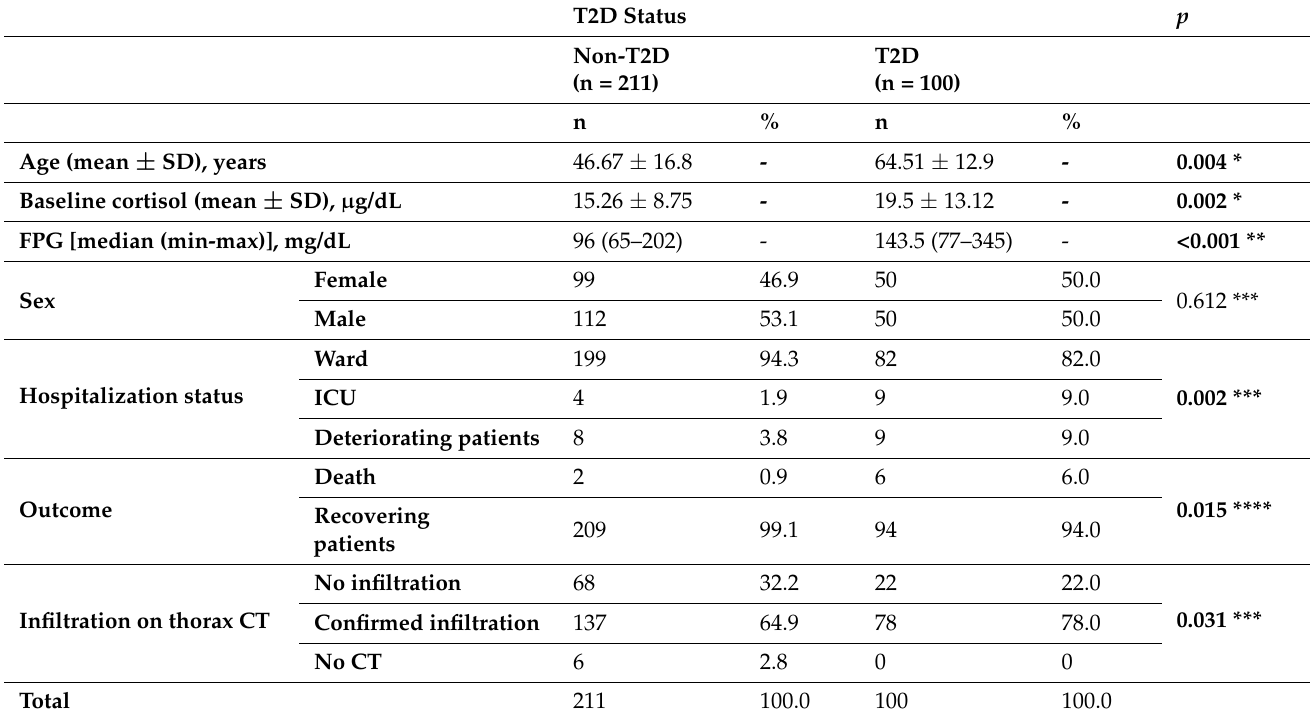
Table 2. Comparison of age, sex, basal cortisol, FPG, hospitalization status, and survey and tomogra- phy findings of patients with and without